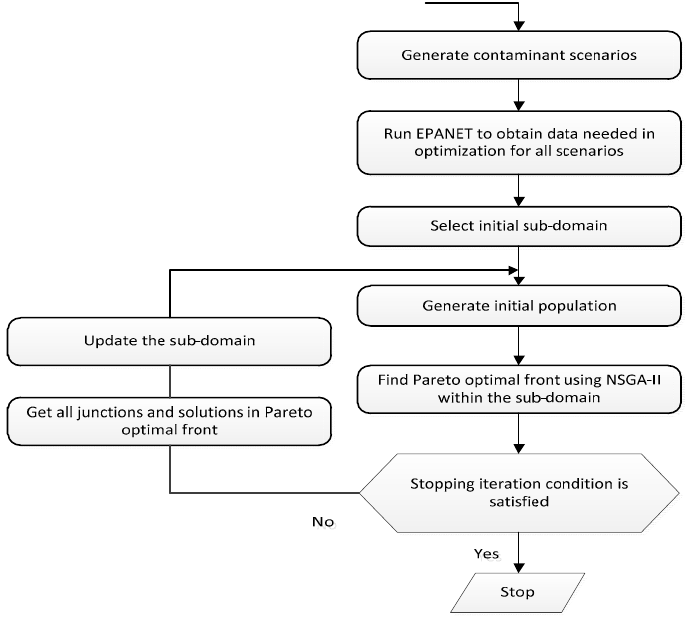
Figure 15. The flow chart of non-dominated sorting genetic algorithm-II (NSGA-II) processes (with permission from ASCE, adapted from [27]).